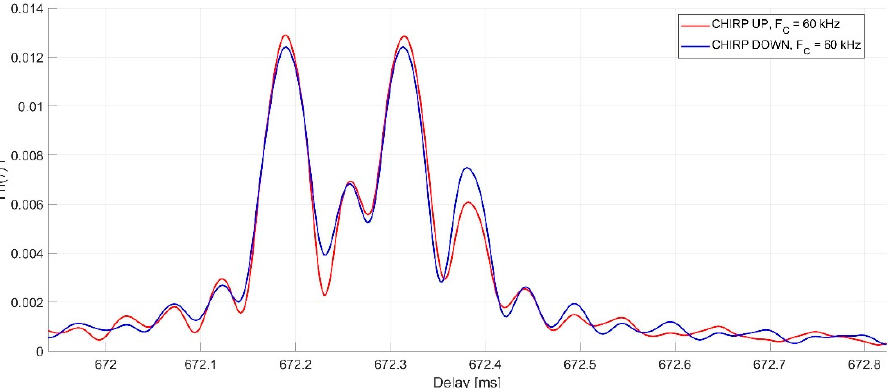
Figure 2. An example of the module of the estimate of impulse responses calculated in a simulation for two different central frequencies in shallow water for a transmitter moving at a speed of 15 m/s.